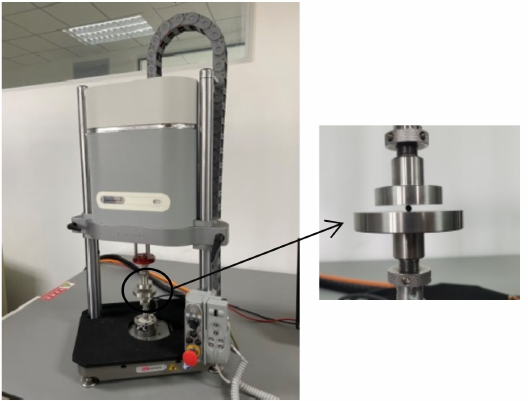
Figure 2. Compression test for granular fungal